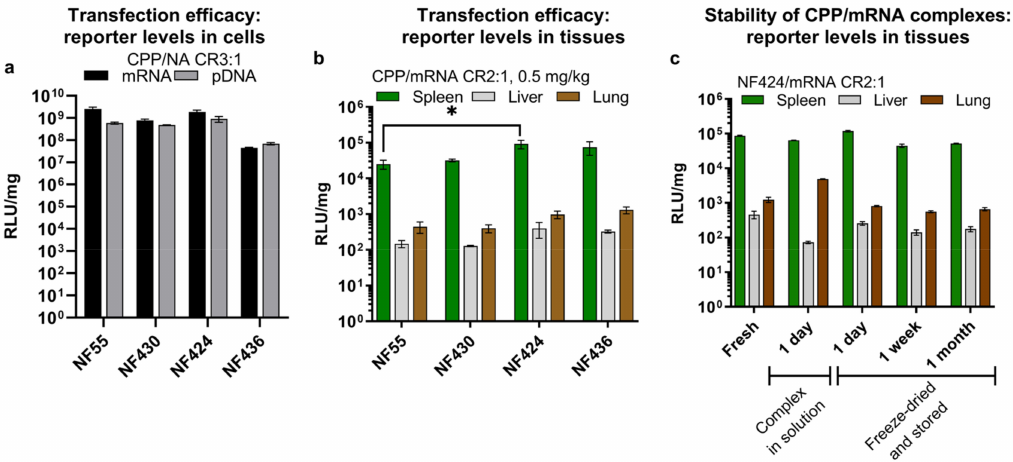
Figure 4. ( a ) Total reporter levels in CHO-K1 after transfection of mRNA or pDNA. A total of 10,000 CHO-K1 cells were seeded one-day prior to transfection on a 96-well plate in 100 µ L of serum-containing media. On the transfection day, the media was replaced with fresh media and CPP/NA complexes formed at a charge ratio (CR) of 3:1 were added to the cells. Per each 96-well plate well, 0.1 µ g of NA was used. At 24 h post-transfection, cells were washed, lysed, and cell lysate relative luminescence (RLU) was detected after the addition of substrate. RLU is normalized to establish the total protein in the sample (RLU/mg). ( b ) Luciferase reporter levels achieved in vivo. At 16 h post-administration of CPP/mRNA complexes, tissues were harvested and tissue homogenate reporter levels were detected. Two-way ANOVA F(6, 60) = 2.0, p = 0.07, Tukey post-hoc comparison: * = p < 0.05. ( c ) In vivo comparison of freshly prepared complexes to a complex solution incubated at +4 ◦ C or freeze-dried complexes stored for 1 day, 1 week, or 1 month. Tissues were harvested 16 h